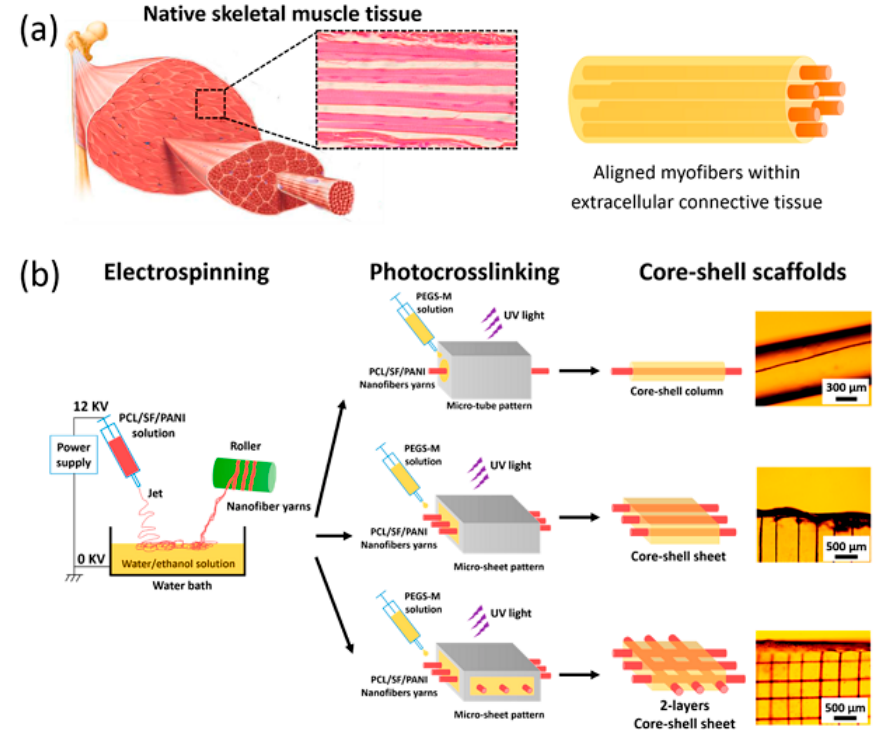
Figure 10. ( a ) Composite similar to the skeletal muscle structure, contain aligned myofibers formed through myoblast fusion together into multinucleated myotubes surrounded within the extracellular connective tissue. ( b ) Scheme of scaffolds fabrication [259], copyright American Chemical Society,